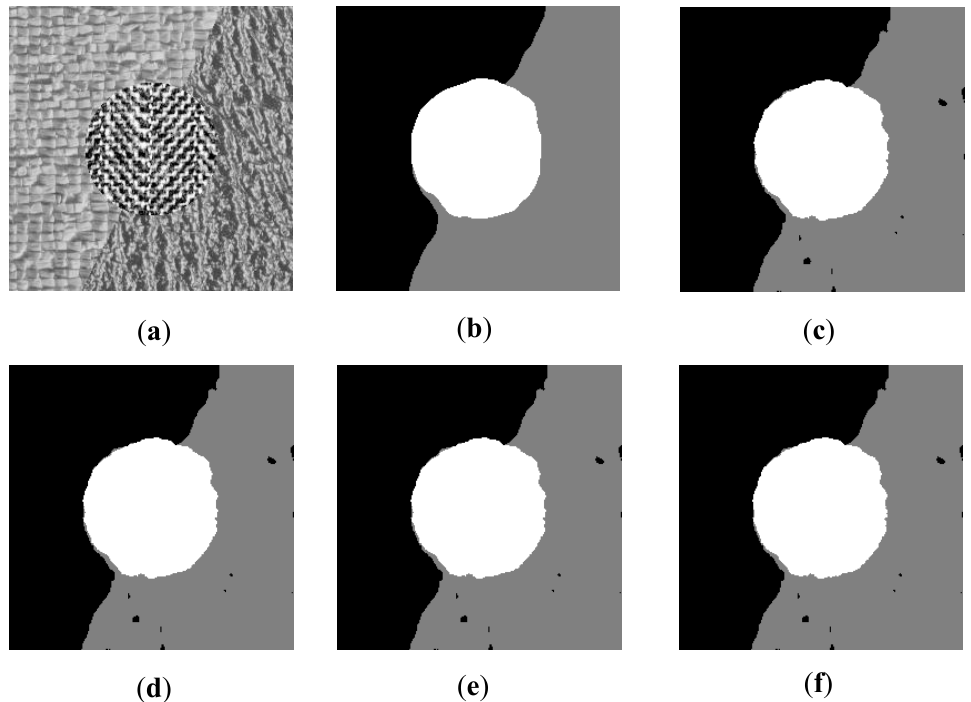
Figure 6. Segmentation results on Image5. ( a ) original image; ( b ) AFWDLMO; ( c ) AFCMOMA; ( d ) AFCMDE; ( e ) MoMODEFC; ( f ) FCMNSGA.